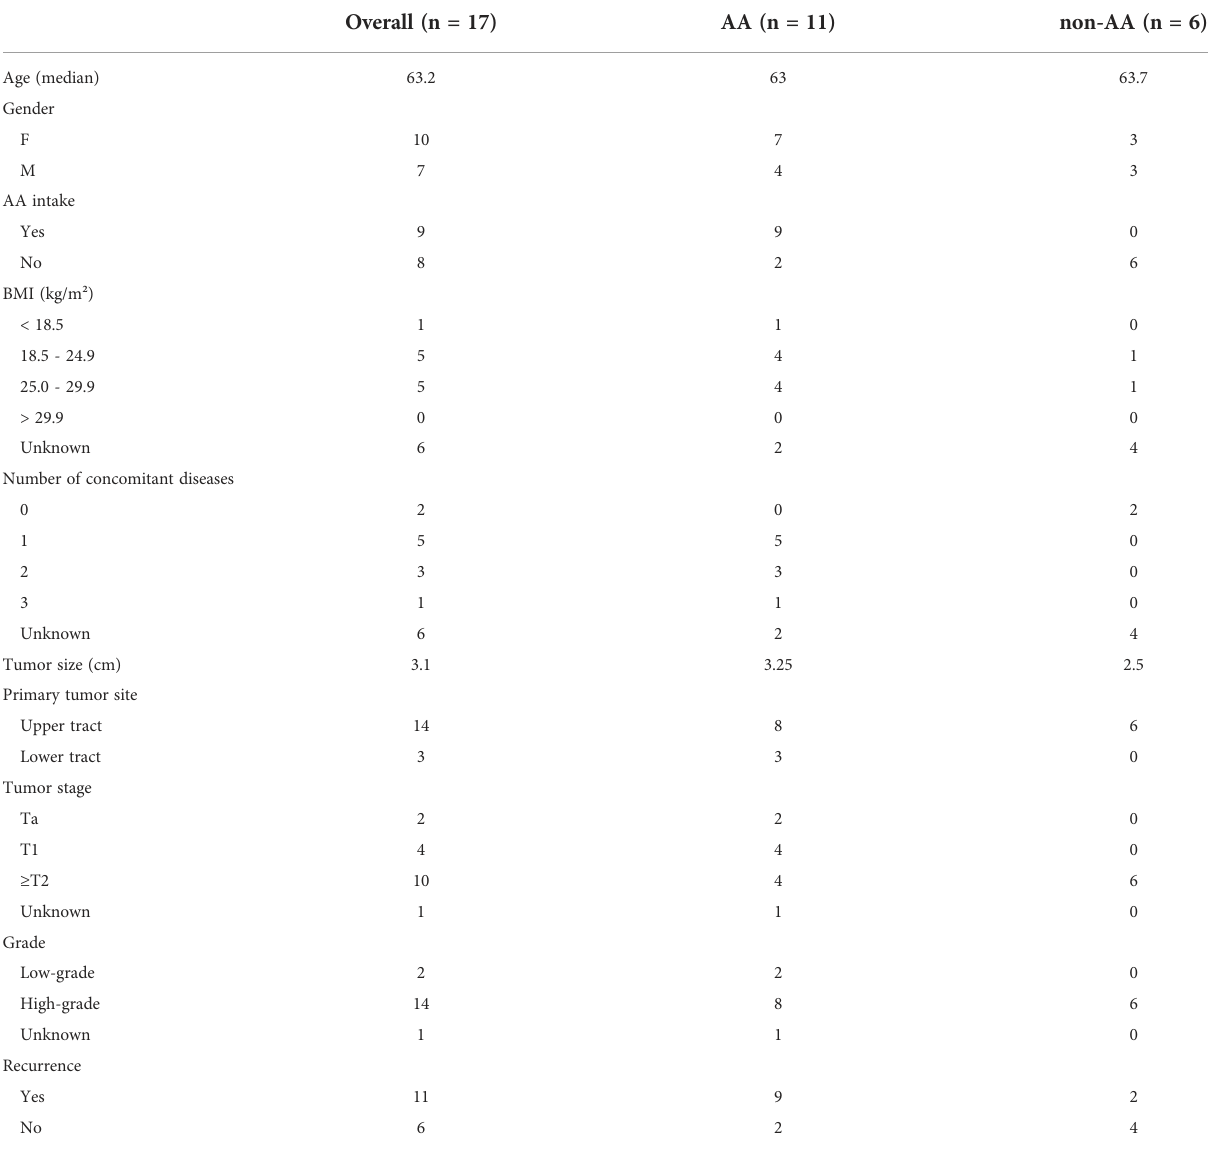
TABLE 1 Patient